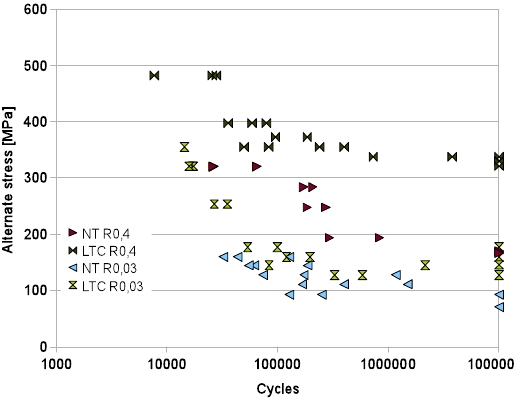
Fig. 4: Effect of different notches on the fatigue life